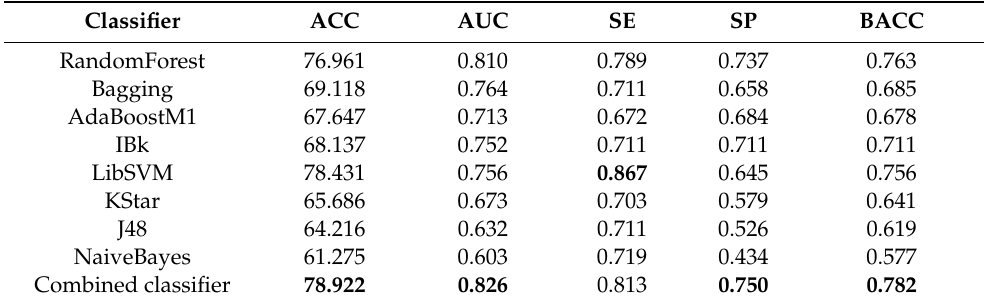
Table 4. Performance of the eight best single classifiers and the combined classifier on the integrated external validation